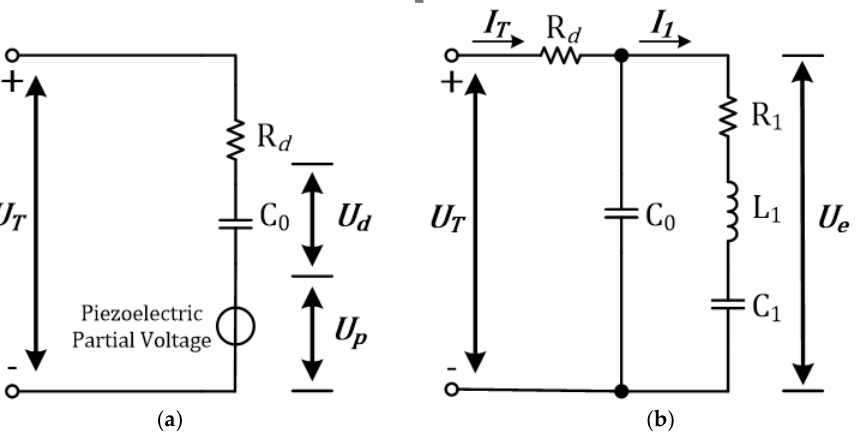
Figure 3. ( a ) The electrical model and ( b ) the equivalent circuit model of a high-power piezoelectric system.